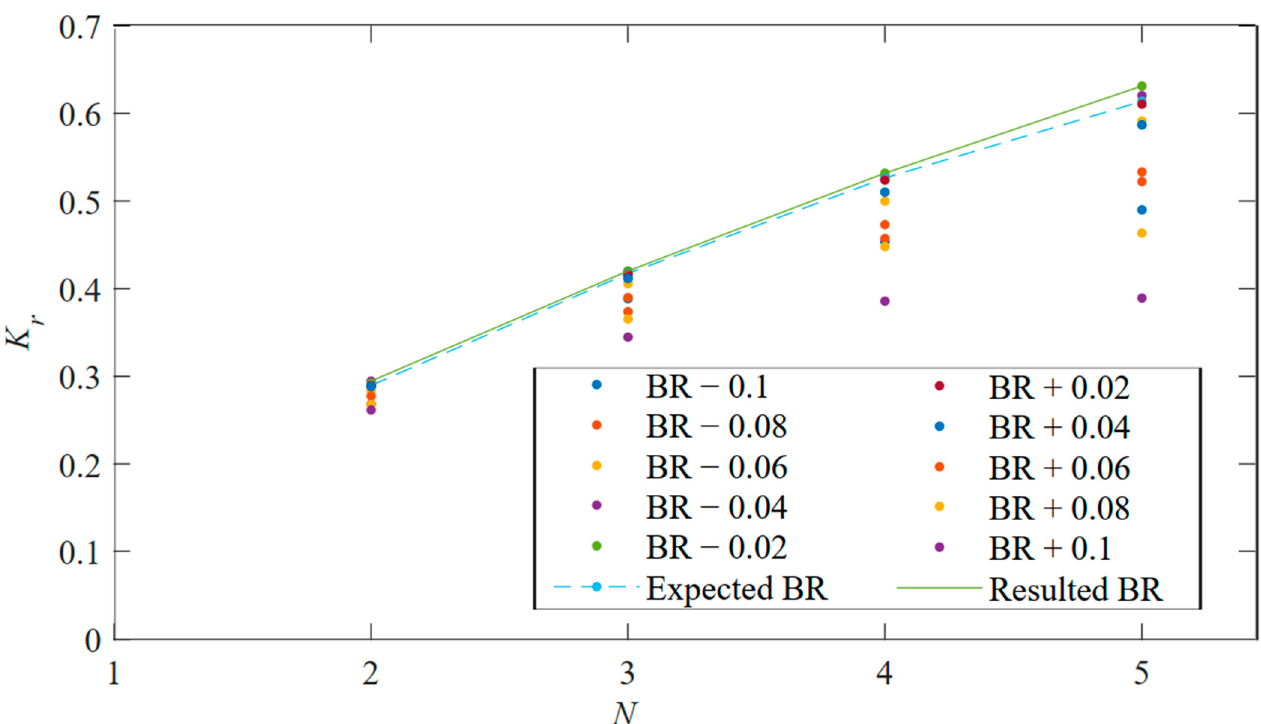
Figure 14. Bragg resonance of multiple periodically submerged breakwaters with 1.0 m wavelength at 0.2 m water depth.